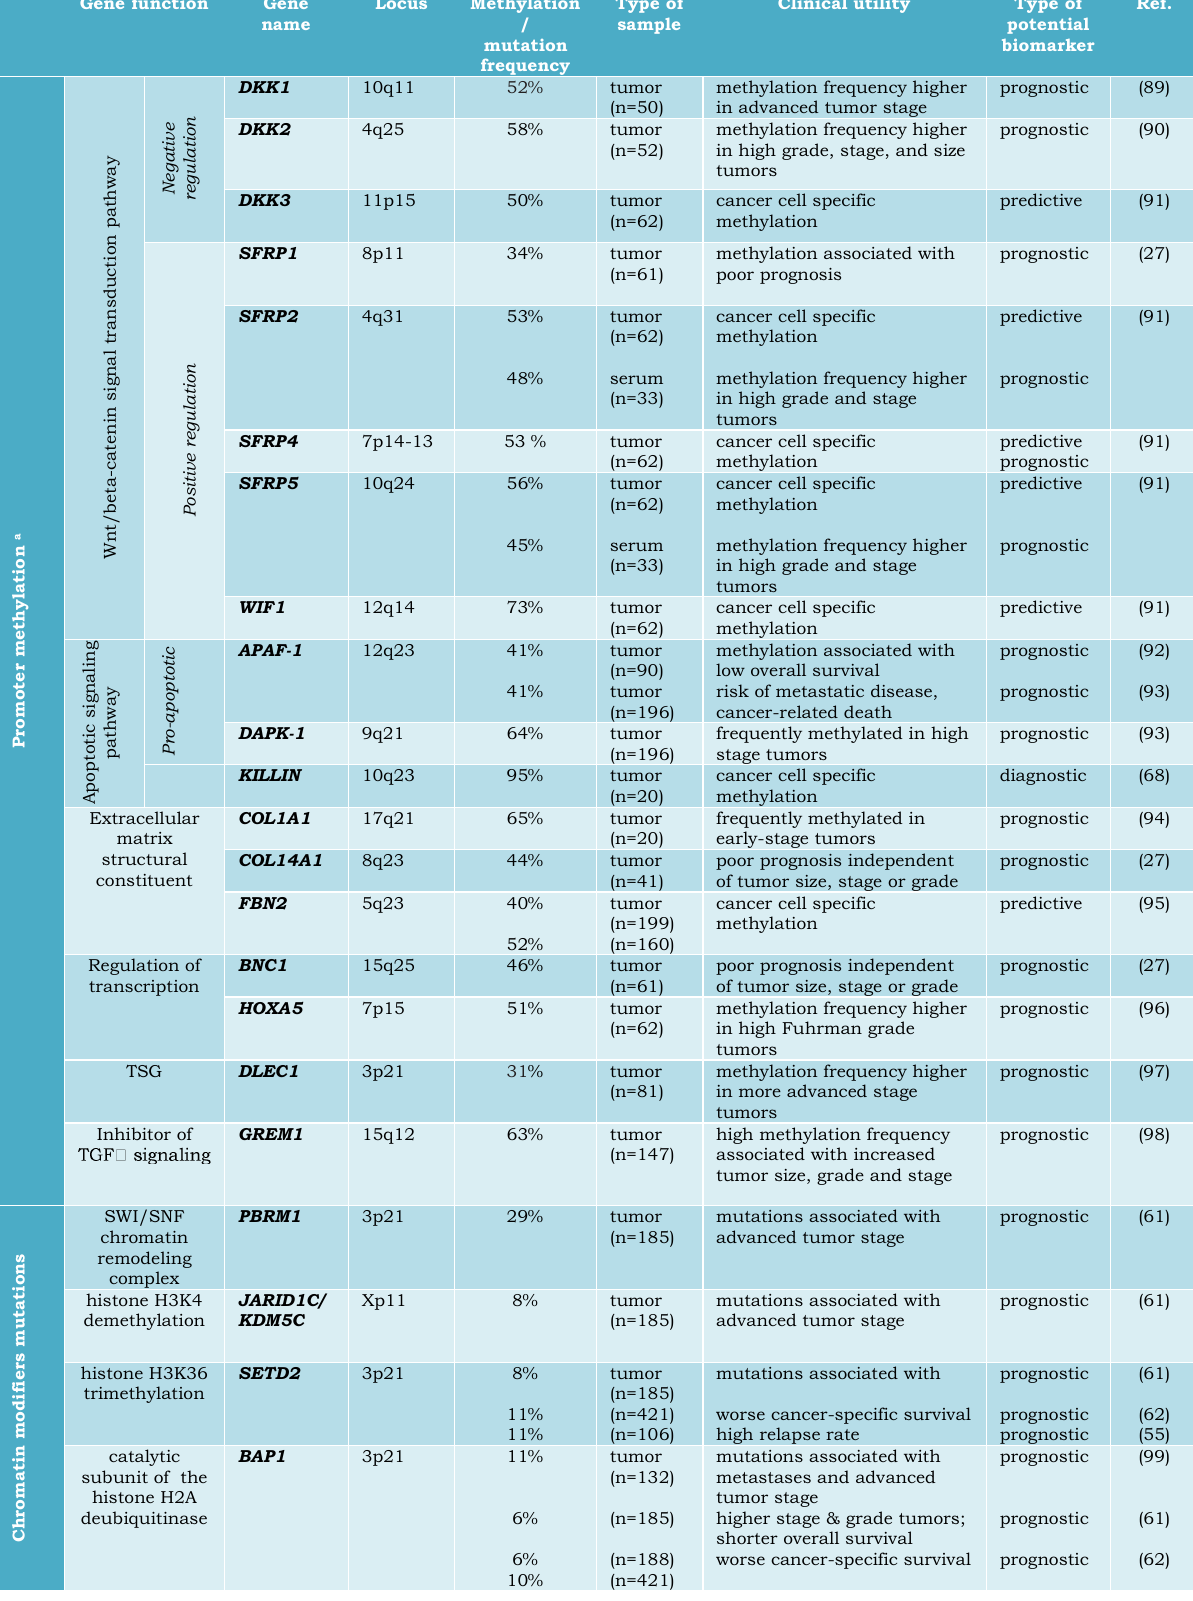
Table 1. Genes involved in epigenetic DNA and chromatin modifications, proposed as potential biomarkers in ccRCC ( a genes with methylation frequency above